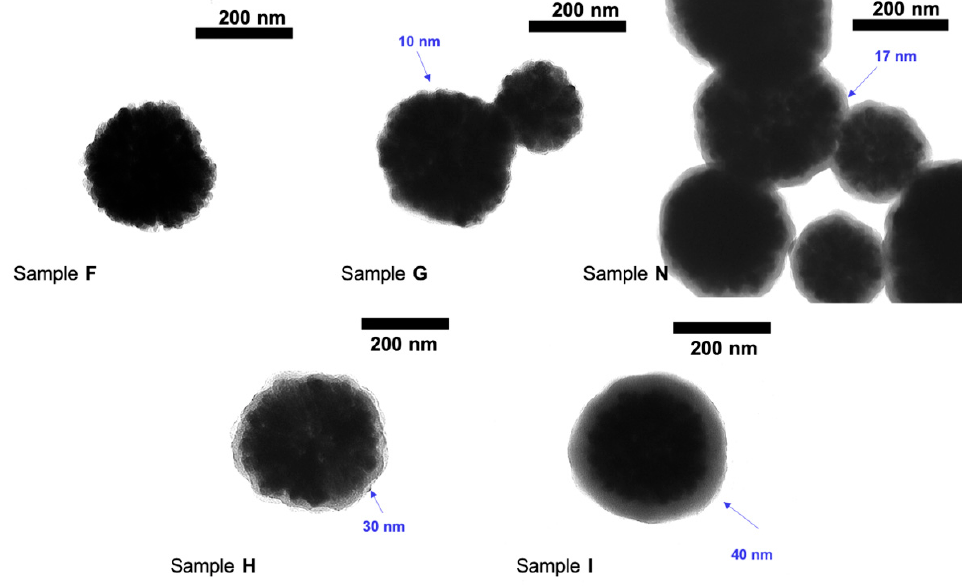
Figure 5. TEM images of Sc-MNPs showing an increase in the thickness of the silica layer with re- spect to change in concentration of aq. ammonia, sample F = 0.01 M, sample G = 0.05 M, sample N = 0.1 M, sample H = 0.25 M and sample I = 0.5